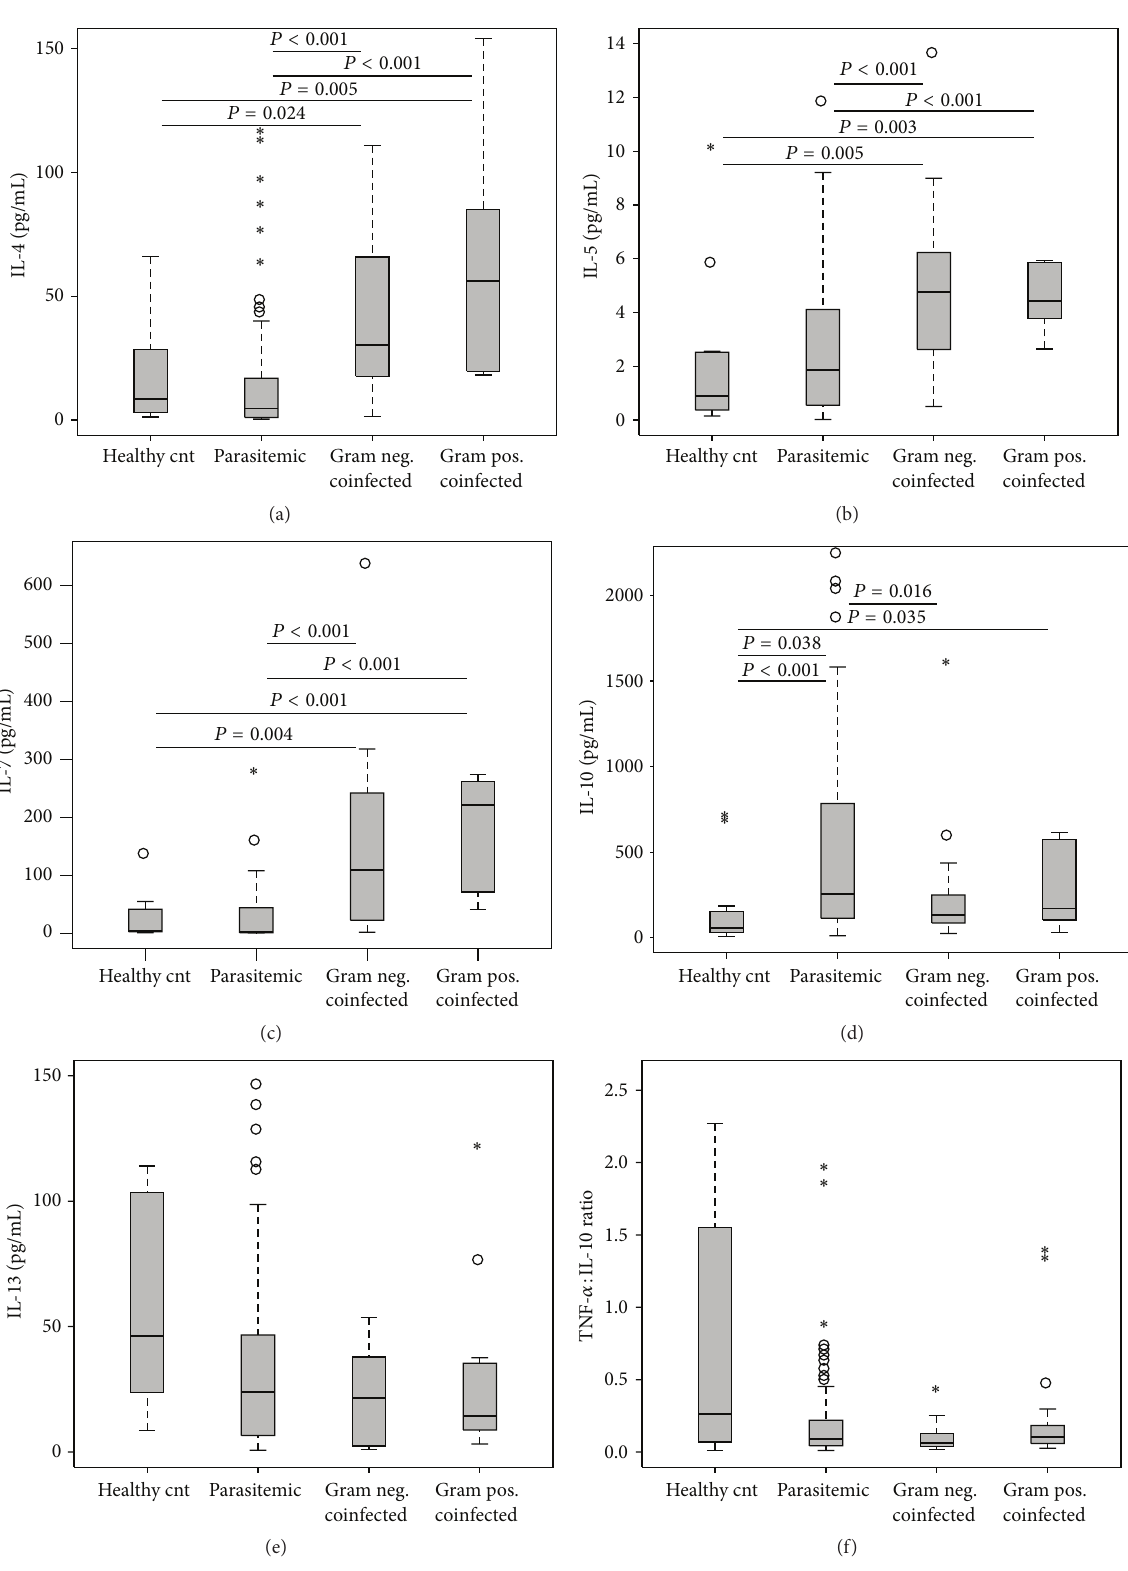
Figure 4: Anti-inflammatory mediator profiles. Data are presented as box plots with whiskers and outliers. The box represents the interquartile range, while the whiskers represent the 10th and 90th percentiles. The line across the box indicates the median value, open circles ( ∘ ) represent extremes, and asterisks ( ∗ ) depict outliers. Pair-wise comparisons between groups were conducted with Mann-Whitney 𝑈 test. All units are in pg/mL. (a) IL-4 (Kruskal-Wallis [K-W], test 𝑃 < 0.001 ). (b) IL-5 (K-W test, 𝑃 < 0.001 ). (c) IL-7 (K-W test, 𝑃 < 0.001 ). (d) IL-10 (K-W test, 𝑃 = 0.042 ). (e) IL-13 (K-W test, 𝑃 = 0.366 ). (f) TNF- 𝛼 : IL-10 ratio (K-W test, 𝑃 = 0.329